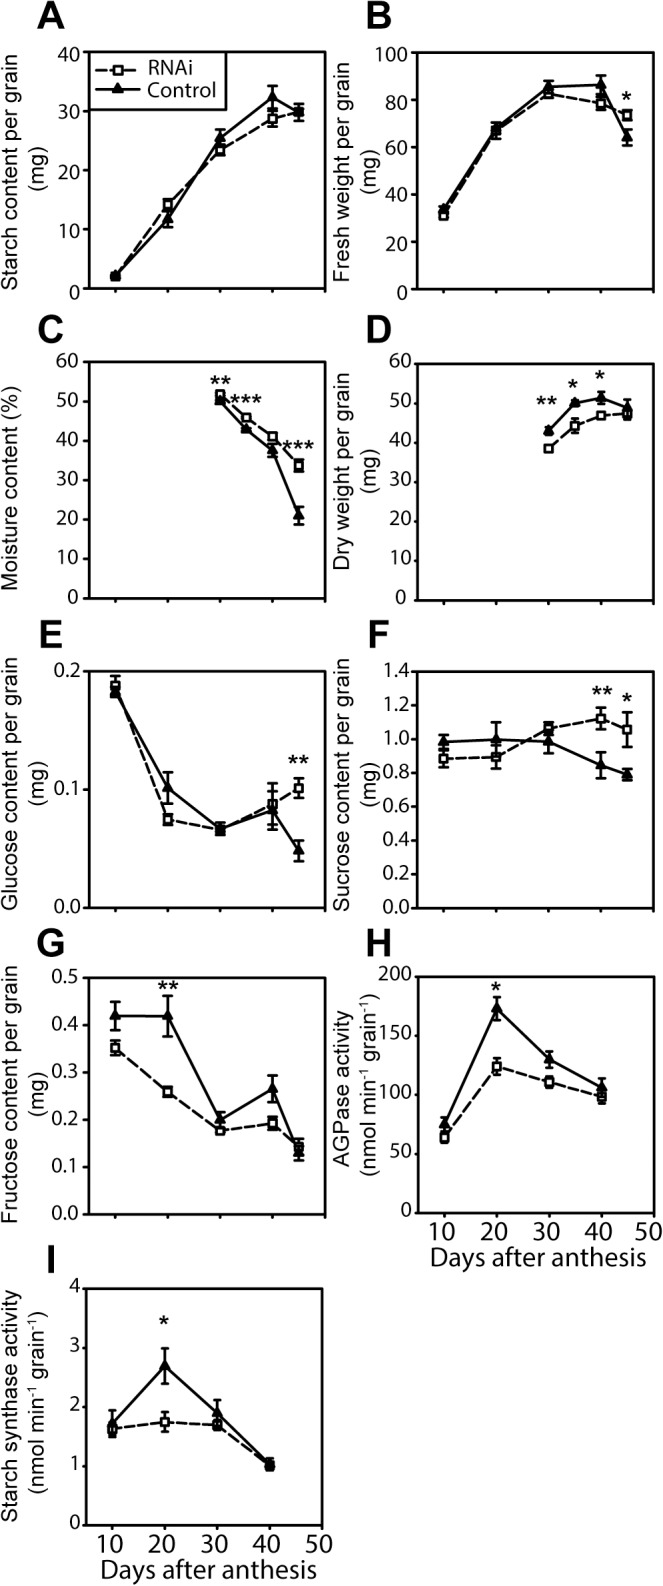
Grain filling parameters in L19 NAM RNAi (open squares) and control (filled triangles) plants.(A) Starch content, (B) fresh weight, (C) moisture content, (D) dry weight, (E) glucose content, (F) sucrose content, (G) fructose content, (H) AGPase activity and (I) starch synthase activity. Values are means of measurements on five or six individual plants (biological replicates), ± SEM. For each plant, measurements were on eight to ten grains from the centre of the main spike. For metabolite and enzyme assays, these grains were pooled to make a single extract per plant. Asterisks denote significant differences between genotypes at p < 0.05 (*), p < 0.01 (**) and p < 0.001 (***).